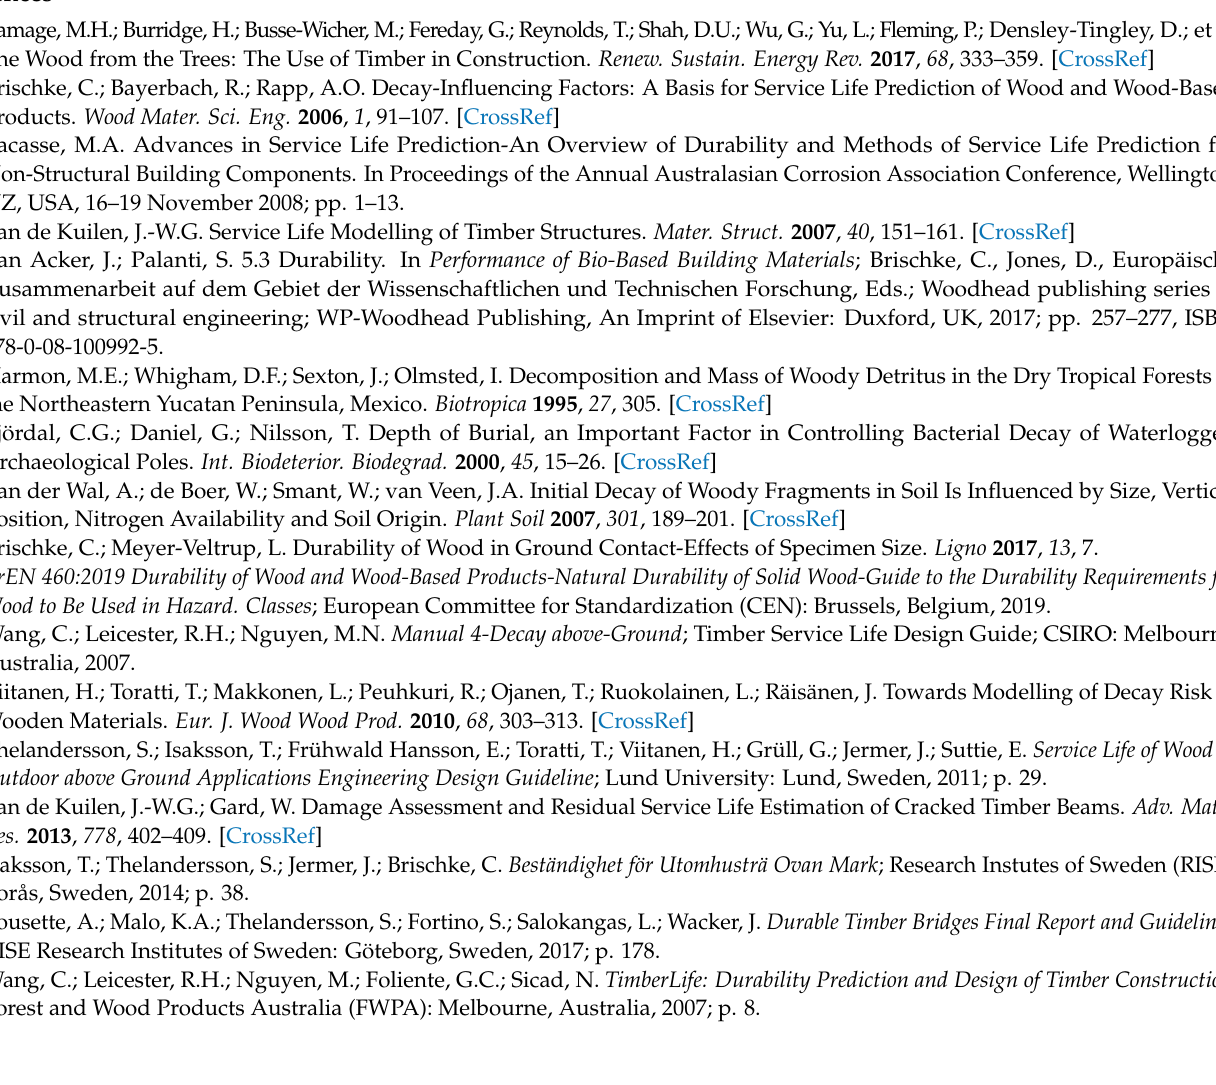
Figure A2. Residuals plotted against fitted values to visually assess homoscedasticity of the residuals of the fitted polynomial function for the temperature-induced dose component model. The straight red line means the point clustering shows no particular trend and the residuals could be considered homoscedastic.